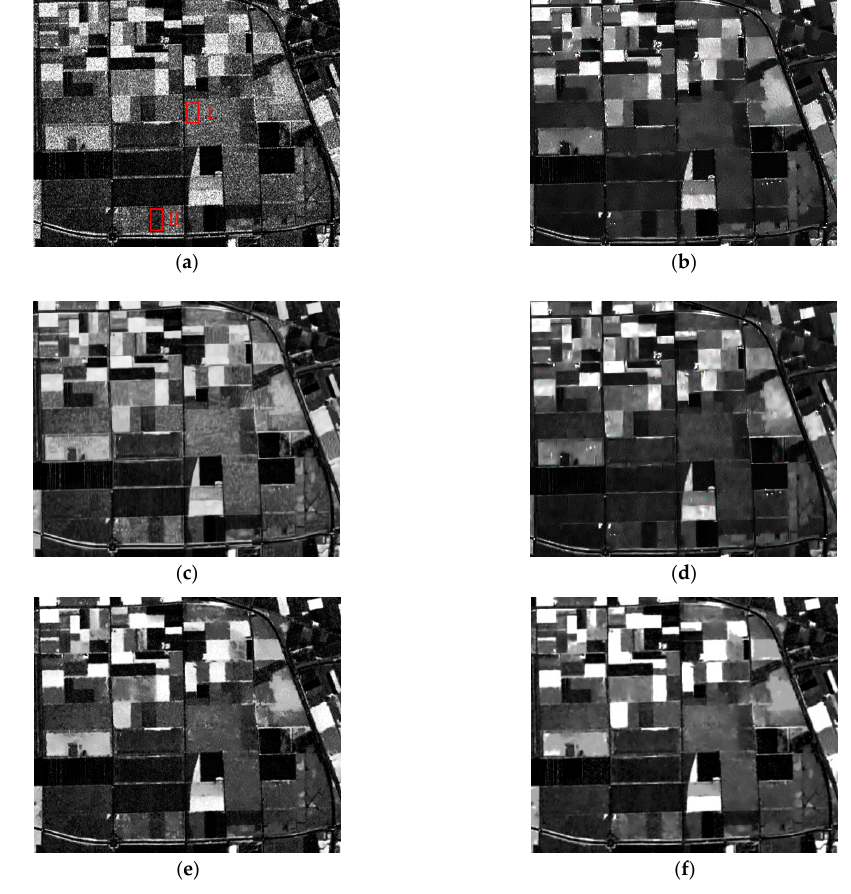
Figure 9. Filtered images for the Flevoland SAR image contaminated by four-look speckle. ( a ) Original image. ( b ) PPB [13]. ( c ) SAR-BM3D [14]. ( d ) SAR-POTDF [16]. ( e ) SAR-CNN [28]. ( f ) SAR-DRN.